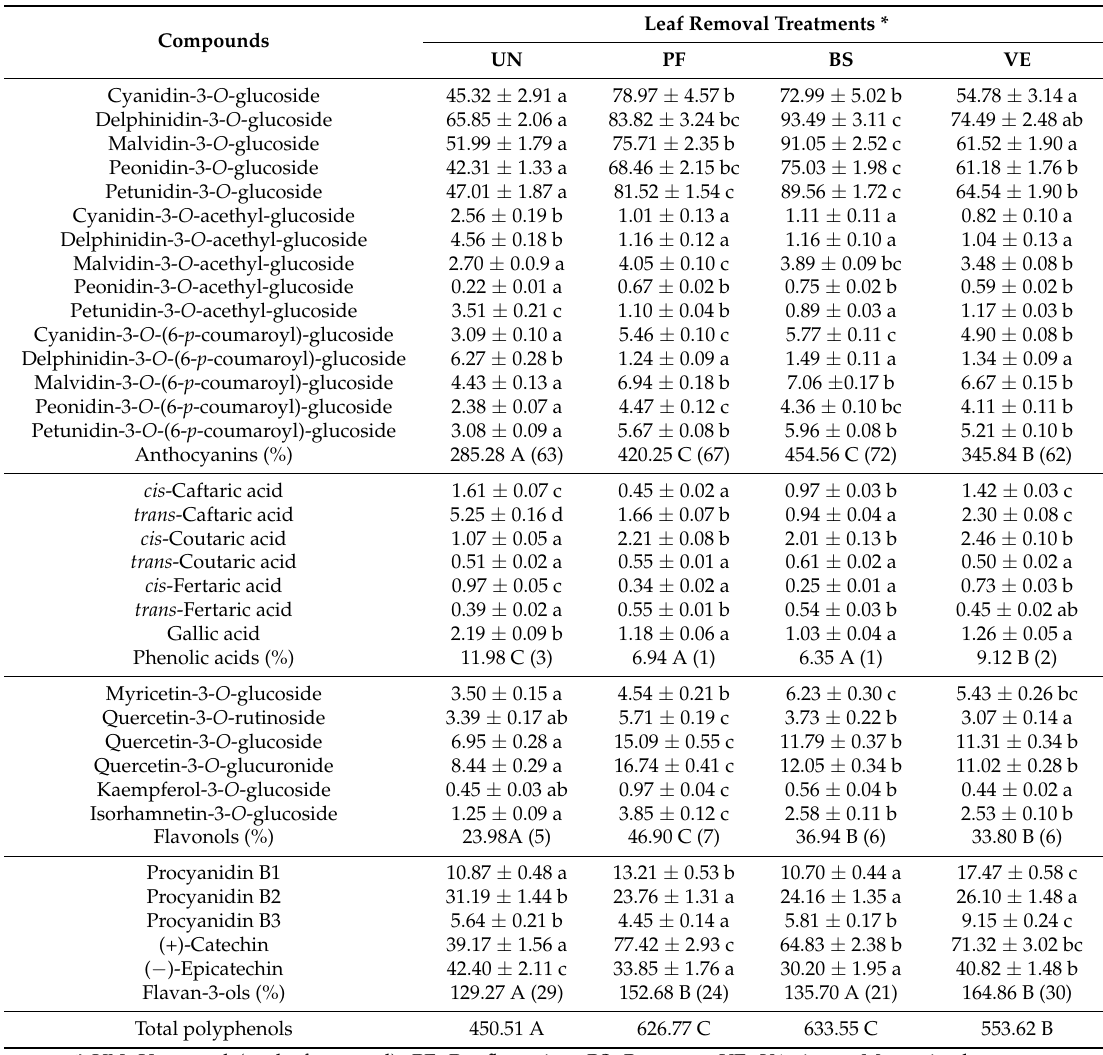
Table 4. The polyphenol content in mg · 100 g − 1 FW of grape cultivar Regent (average for the years 2014–2015) as related to different leaf removal